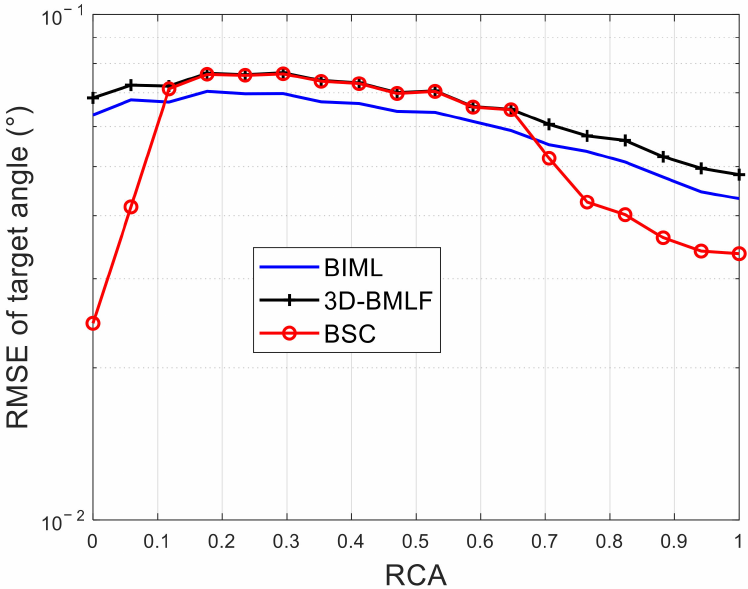
Figure 4. The RMSEs of the target angle for the three algorithms against the RCA. Thirdly, the RMSE of the target angle for the three algorithms is shown against SNR.